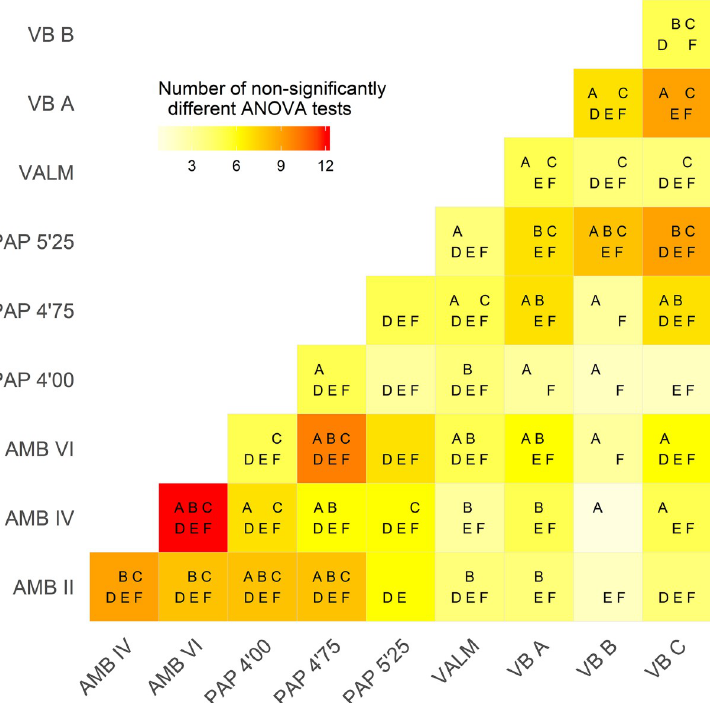
Fig 17. Heat map summarizing the number of non-significantly different bootstrapped ANOVA tests between each pair of assemblages. Letters inside each square indicate the heuristic domains responsible for the similarities between assemblages: A—Platform Maintenance; B—Direction of Core Exploitation; C—Dorsal Surface Convexity; D —Elongated blanks techno-morphology; E—Core Morphology; F—Core Use. For more information on each of the contexts please refer to Table